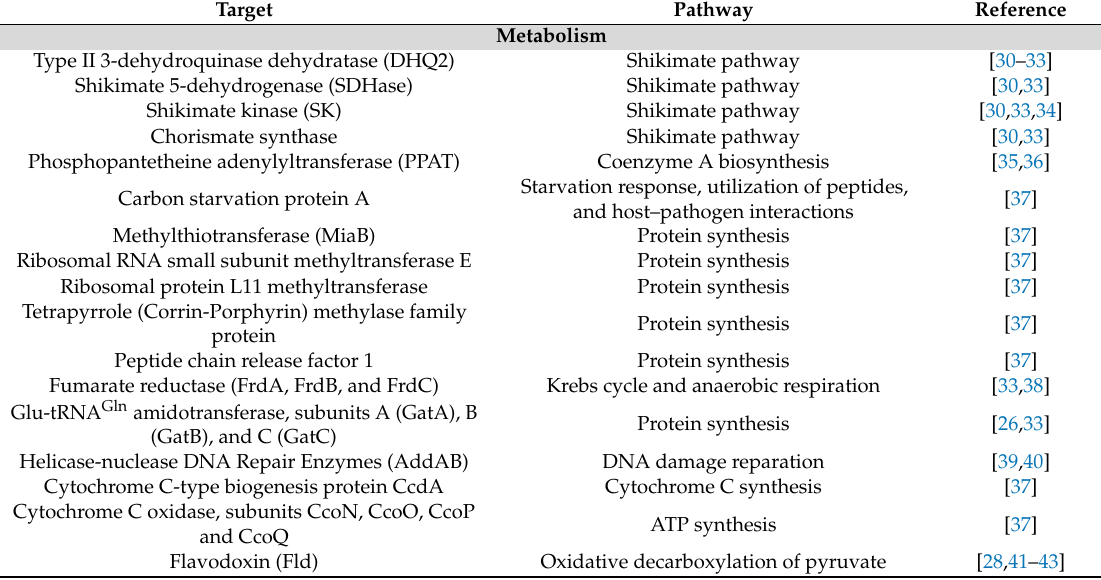
Figure 1. Pathways providing therapeutic targets to fight Helicobacter pylori infection. Table 1. Targets for Hp infection treatment.